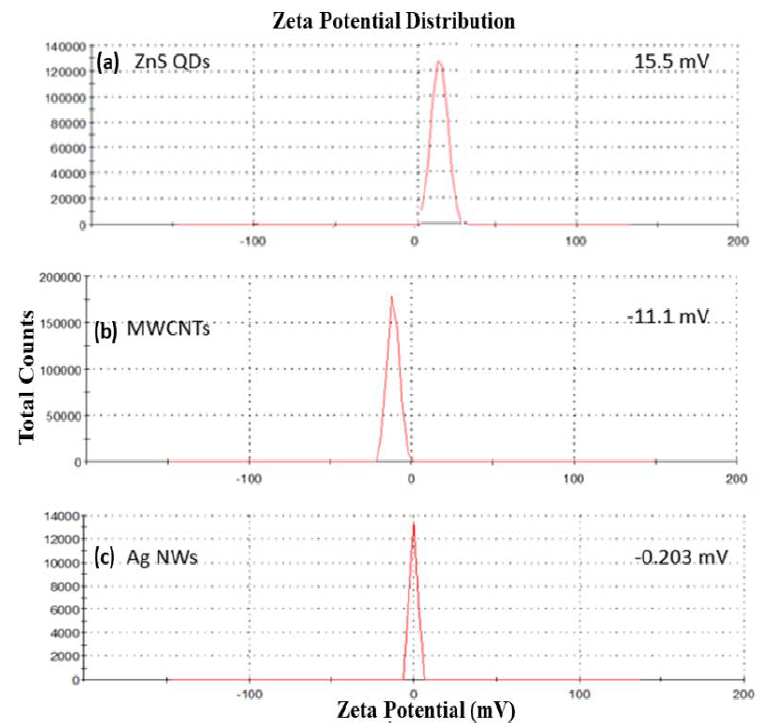
Figure 5. Zeta potential of: ( a – c ).